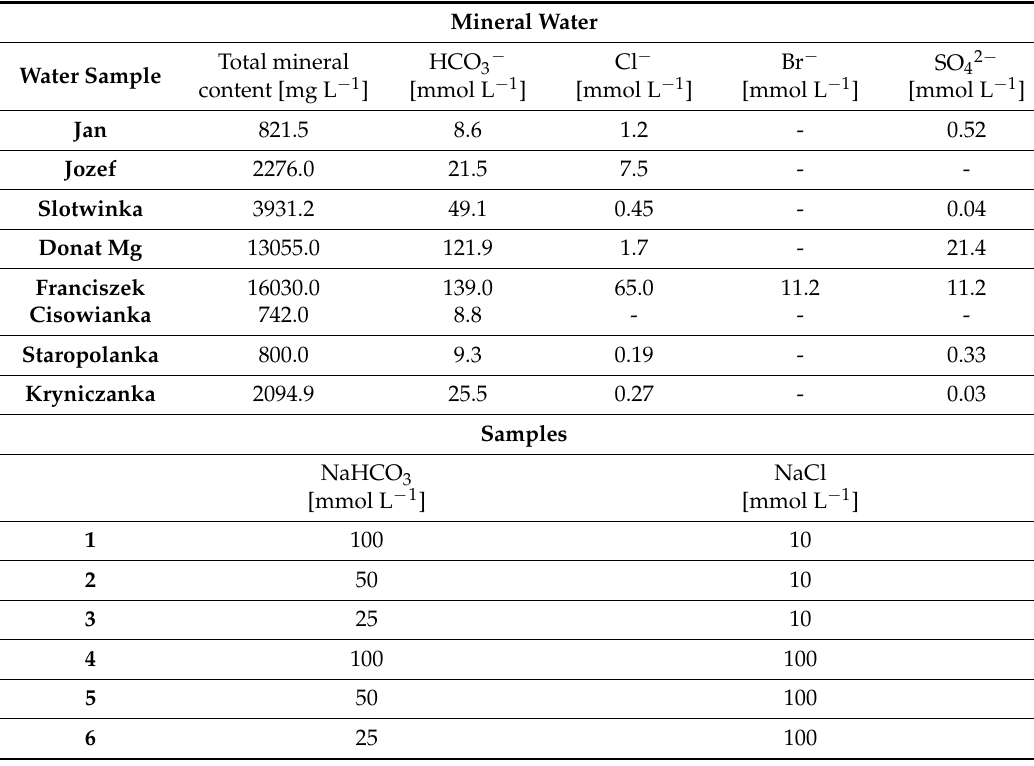
Table 1. Composition of mineral healing waters and mineral water samples from labels of the